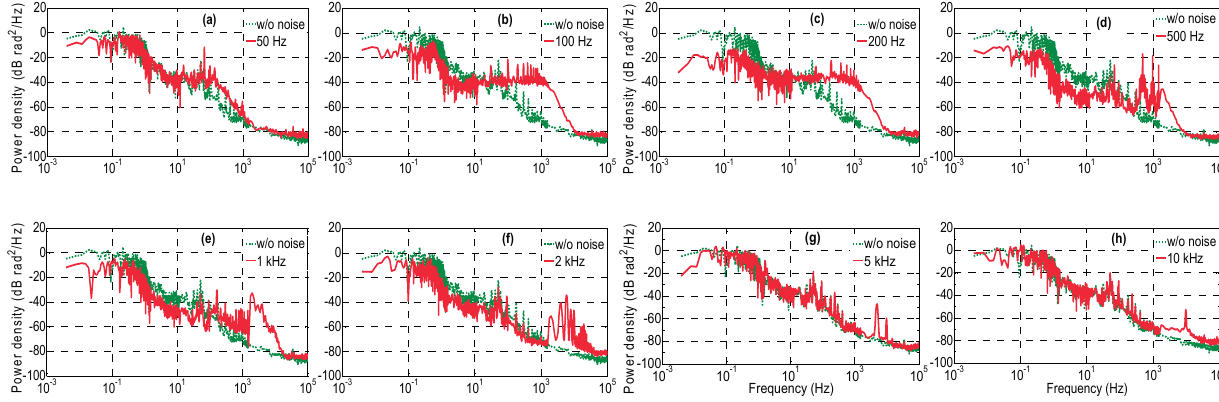
Figure 2. Excess phase noise spectra with (solid) and without (dashed) external acoustic perturbations. Measurement is done with 80 m single-mode fiber (SMF) at eight single-tone perturbation frequencies: ( a ) 50 Hz; ( b ) 100 Hz; ( c ) 200 Hz; ( d ) 500 Hz; ( e ) 1 kHz; ( f ) 2 kHz; ( g ) 5 kHz; and ( h ) 10 kHz. The driving power is the same for all the